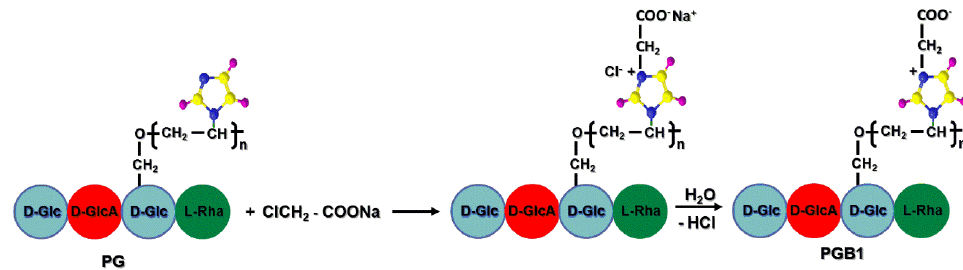
Figure 8. Betainization reaction of PG copolymer with sodium chloroacetate.